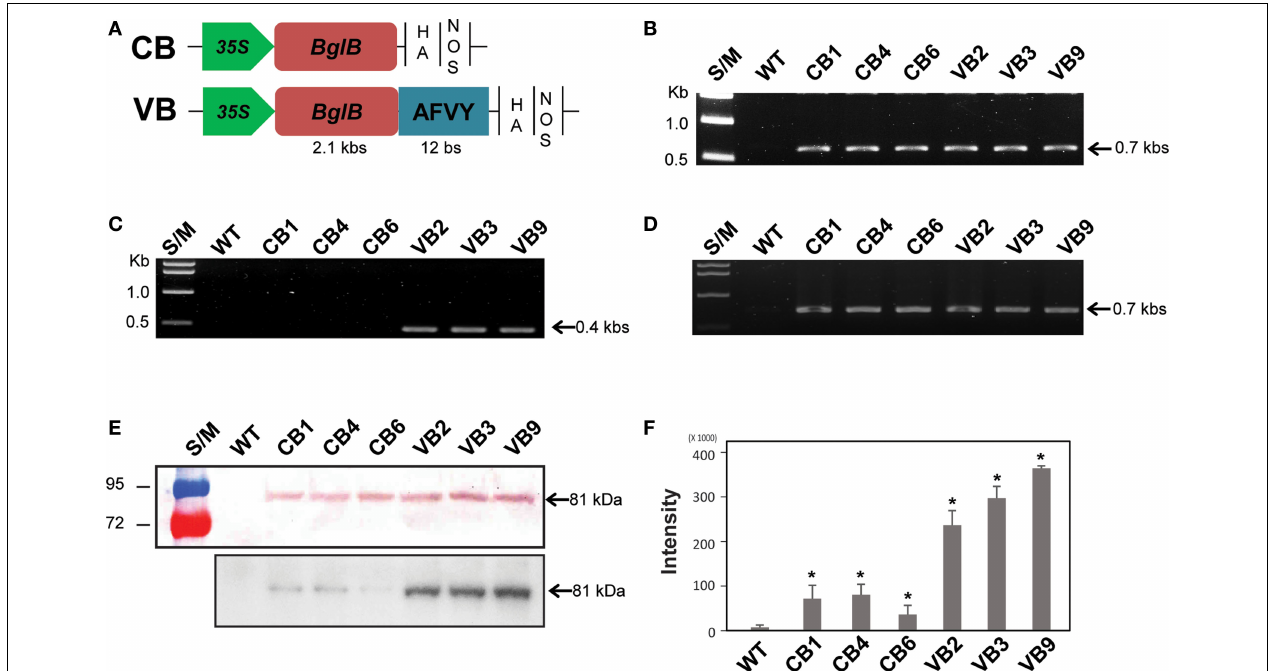
FIGURE 1 | Schematic representation of the BglB expression cassettes and confirmation of heterologously expressed BglB in the transgenic plants . (A) Vector constructions of CB (cytosol-targeted BglB) and VB (vacuole-targeted BglB, with the 12bp represent AFVY tetrapeptide). (B) Confirmation of the presence of BglB in CB and VB constructs in tobacco genome by PCR genomic DNA. (C) Confirmation of the presence of the sequence encoding AFVY tetrapeptide in the C-terminal of BglB of VB transformants by PCR genomic DNA. (D) Confirmation of the transcript sequence encoding BglB in CB and VB constructs after mRNA extraction, cDNA synthesis, and RT-PCR. (E) Confirmation of the presence of heterologously expressed BglB in the transgenic plants, with BglB present in total soluble protein (TSP) extracted from leaf of CB and VB transgenic plants but no from WT plant (above panel, with 10 μ g of TSP was used); and the presence of the heterologous BglB in TSP extracted from isolated vacuole of CB and VB plants but no from those of WT plant (below panel, with 10 μ g of TSP from isolated vacuole was used), after concentrated by UFC 710008/Centricon Plus-70 Centrifugal Filter (EM Millipore, USA) by using fluorophore-conjugated secondary antibody anti-rabbit IgG, incubate with substrate within 5min before transferring to exposure film and keeping within 10min. (F) The intensity of bands exposed in below panel from (E) , measured by Adobe Photoshop CS6. *indicates significant differences from the control (WT) ( P < 0.05).